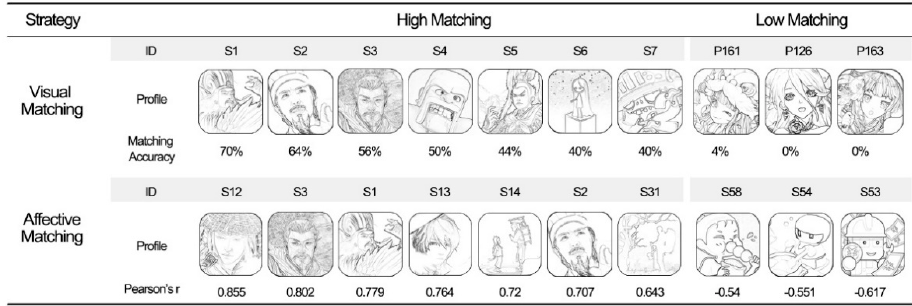
Table 6. Pearson’s r value obtained from correlation analysis.